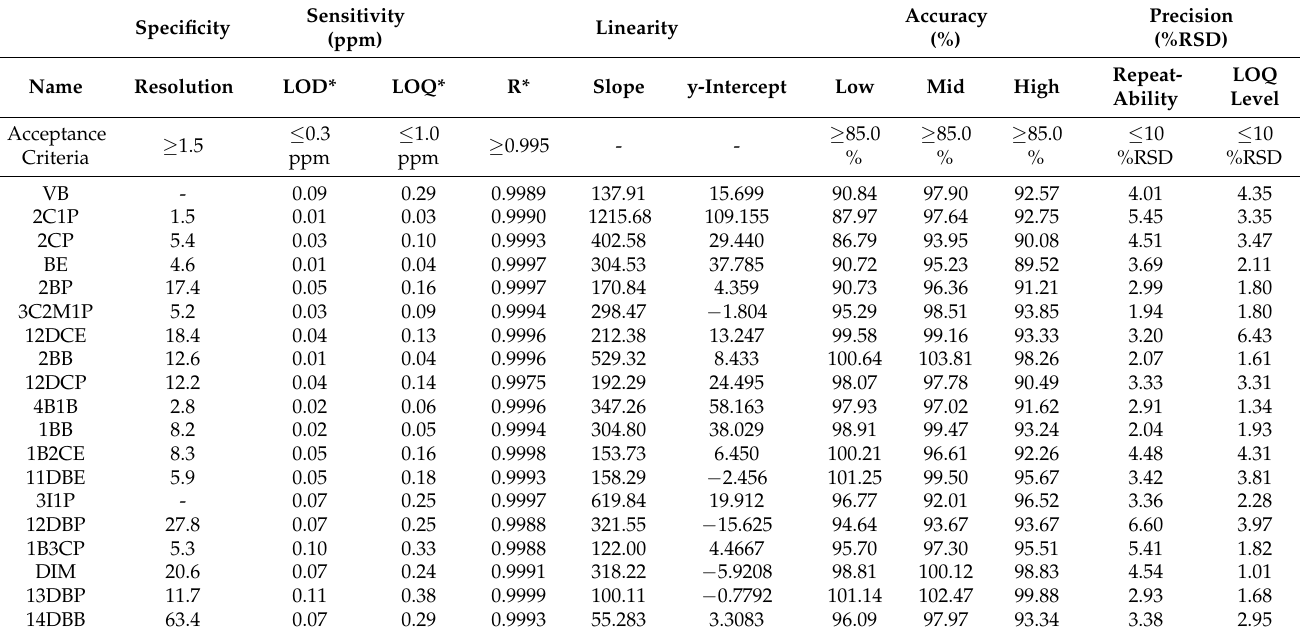
Table 6. Summary of analytical method validation